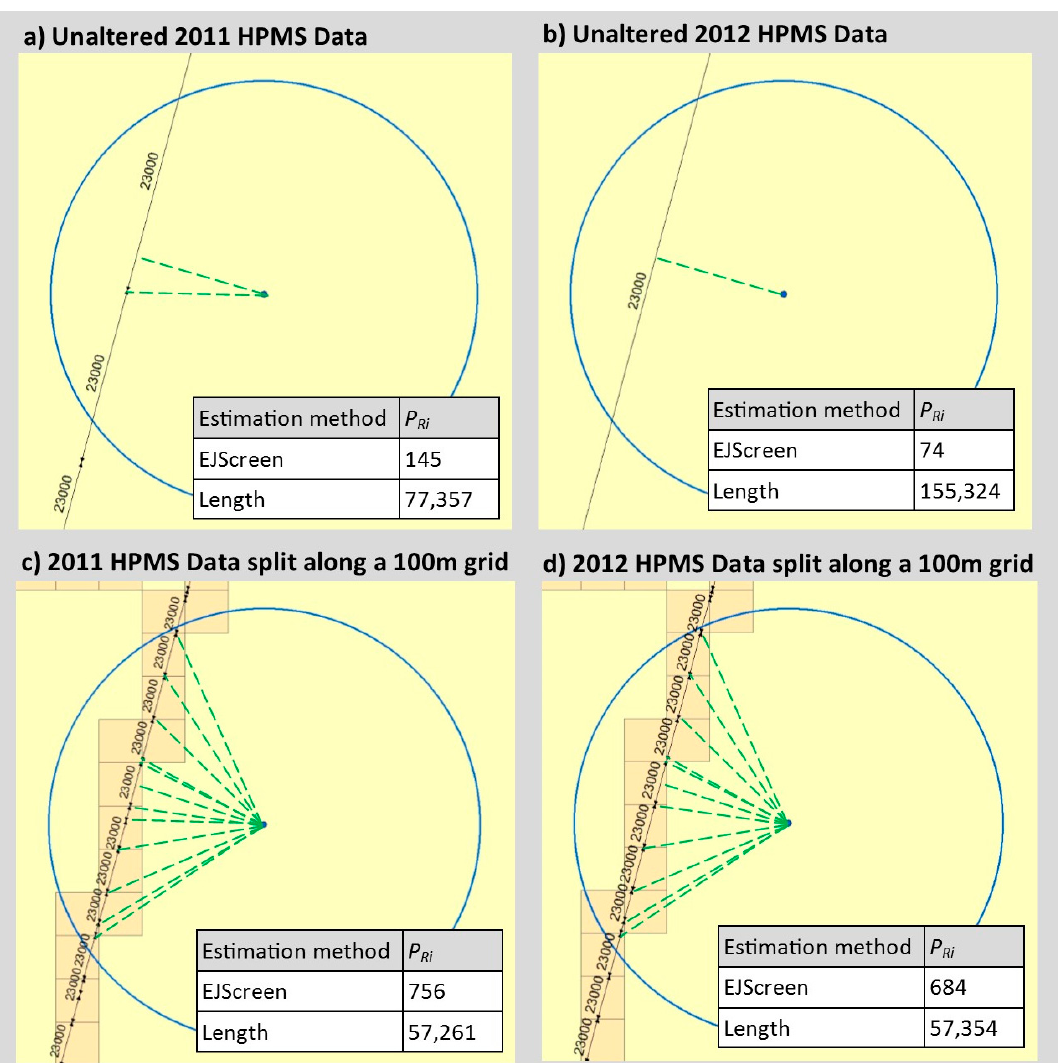
Figure 3. Block level roadway air pollution index calculations for an example census block (Block 482013139001052). The road segmentation varies in each panel but the traffic level is the same (23,000 annual average daily traffic). Each panel illustrates the block centroid, a 500 m circular buffer around the block centroid, nearby highway performance monitoring system (HPMS) road segments, dashed lines connecting the block centroid to the nearest part of each road segment, and the EJScreen and Length estimates for the block. Panel ( a ) shows unaltered 2011 HPMS data, panel ( b ) shows unaltered 2012 HPMS data ( c ) shows 2011 HPMS data split along a 100 m grid, and ( d ) shows 2012 HPMS data split along a 100 m grid.